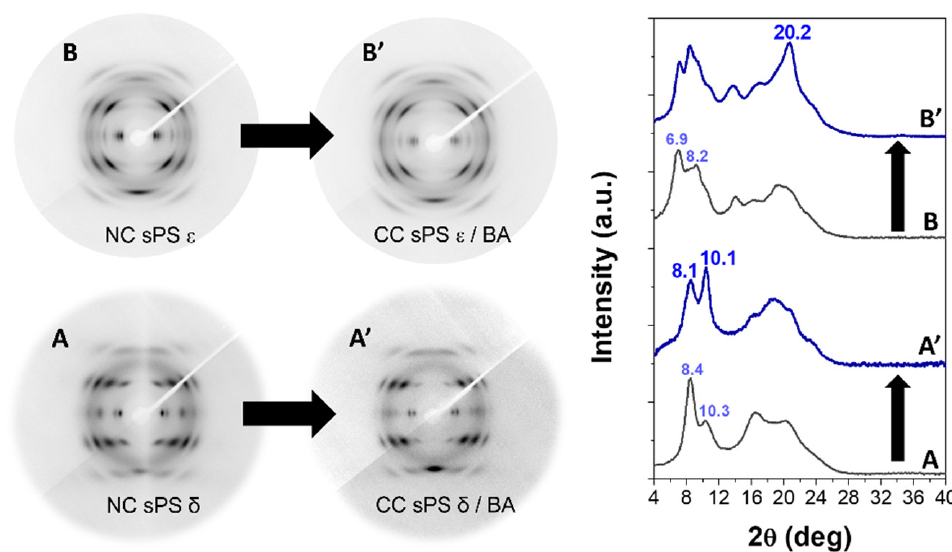
Figure 1. Two-dimensional WAXD fiber patterns and related equatorial intensity profiles of sPS films presenting nanoporous crystalline (NC) and co-crystalline (CC) δ ( A , A’ ) and ε ( B , B’ ) phases. Diffraction angles of relevant reflections of NC and CC phases are indicated.